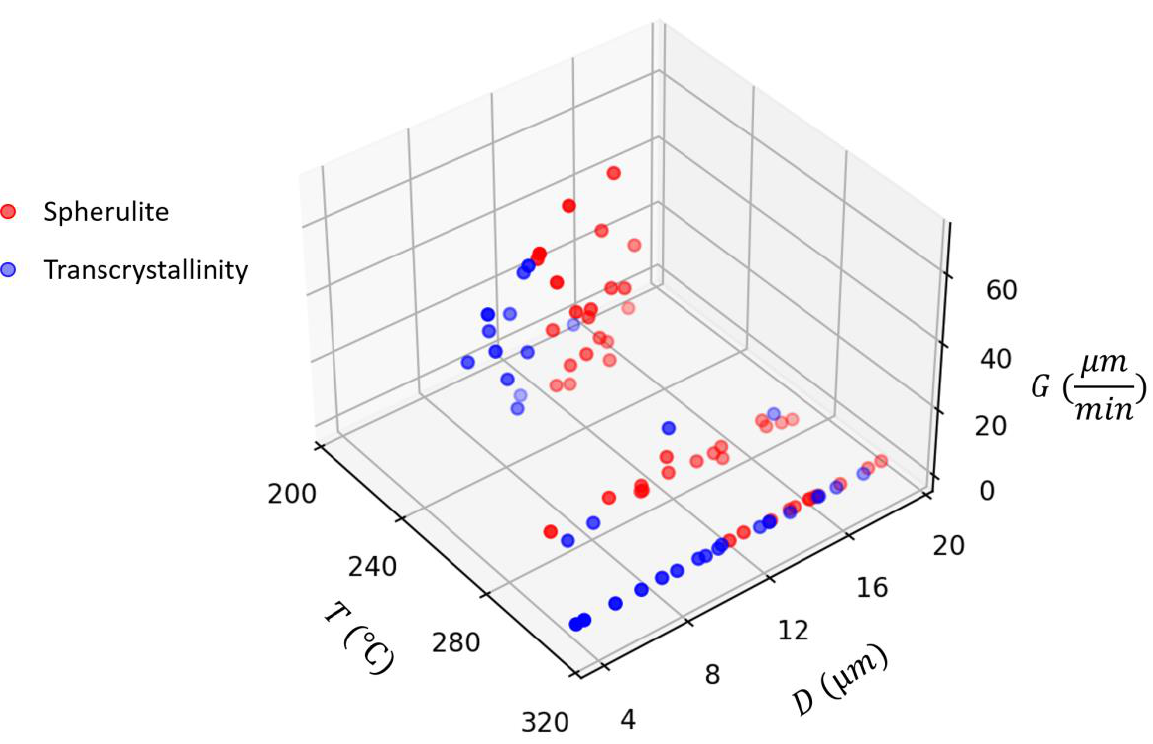
Figure 6. Growth rate data ( G ) measured from microscopy videos at different temperatures ( T ) and for different crystal sizes ( D ).